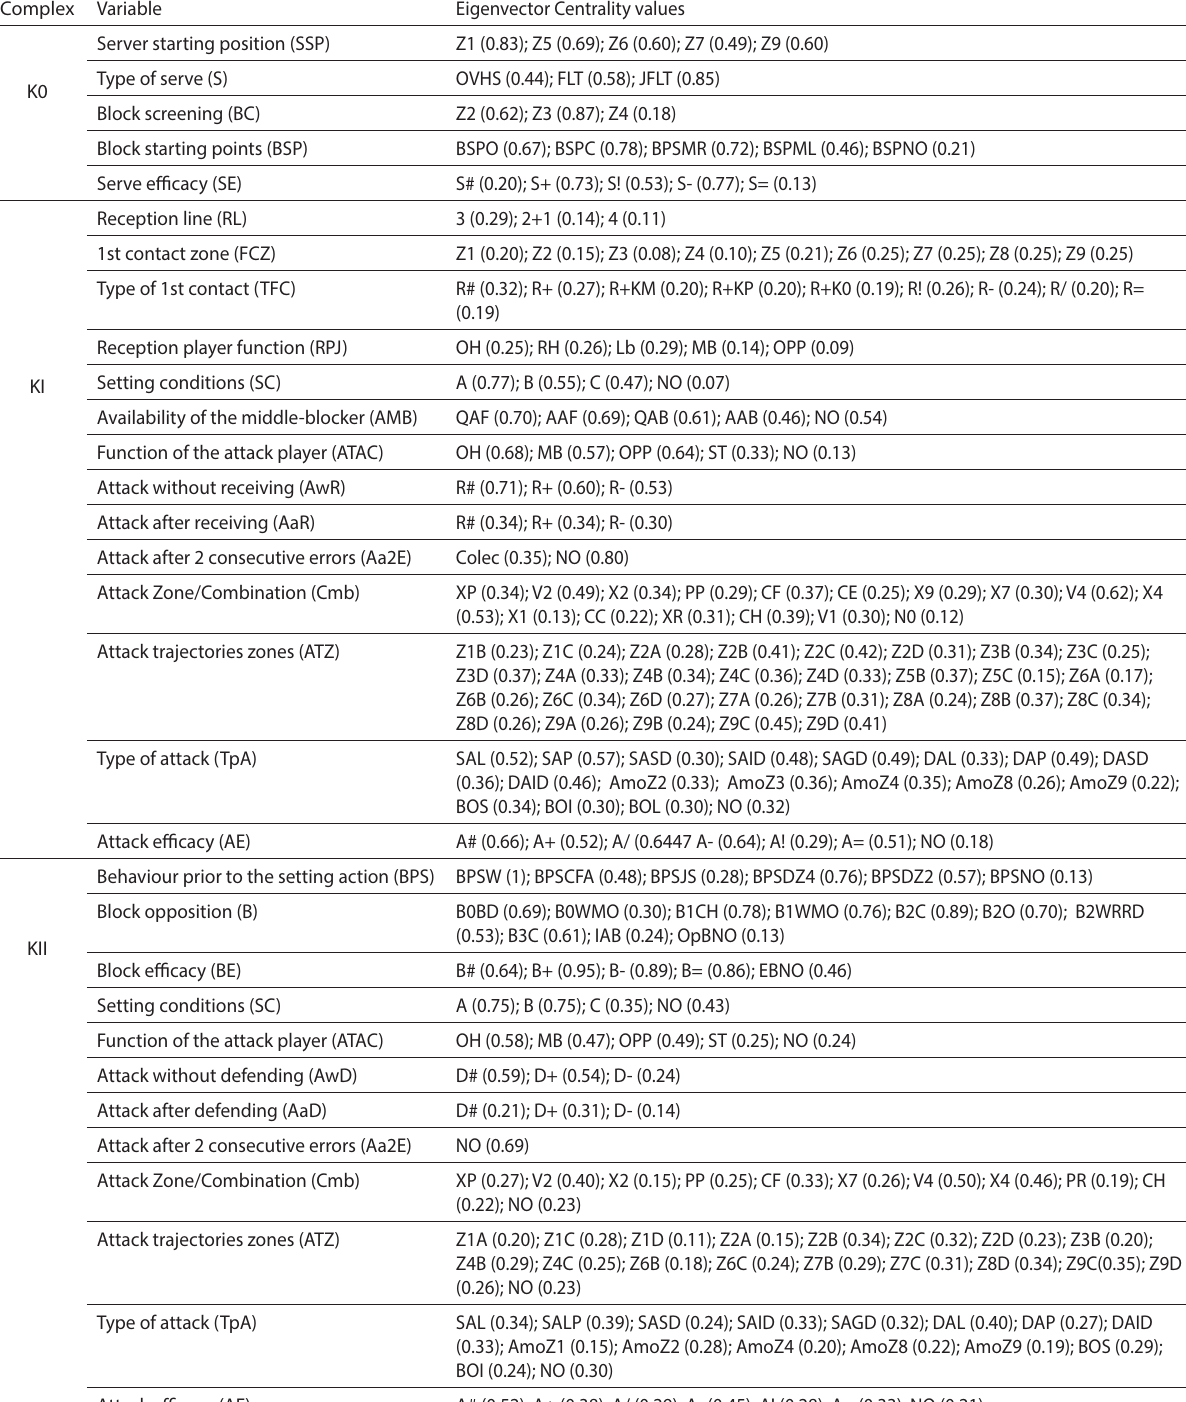
Table 2. Eigenvector Centrality values for